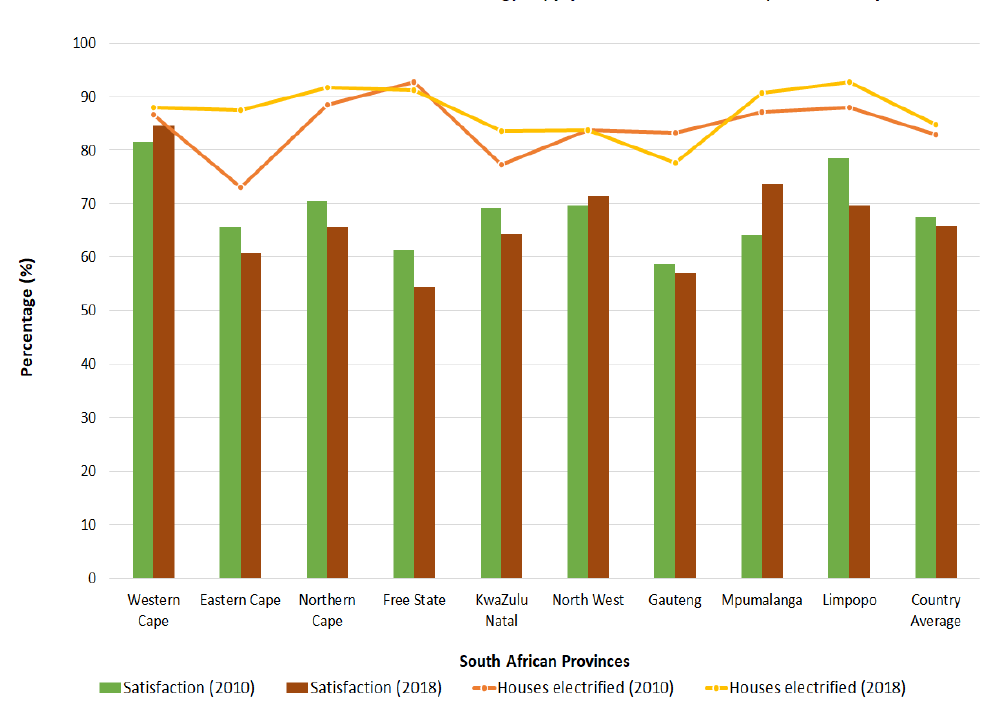
Figure 1. South Africa electrification status and overall customer satisfaction (generated from data presented in the South African Census report